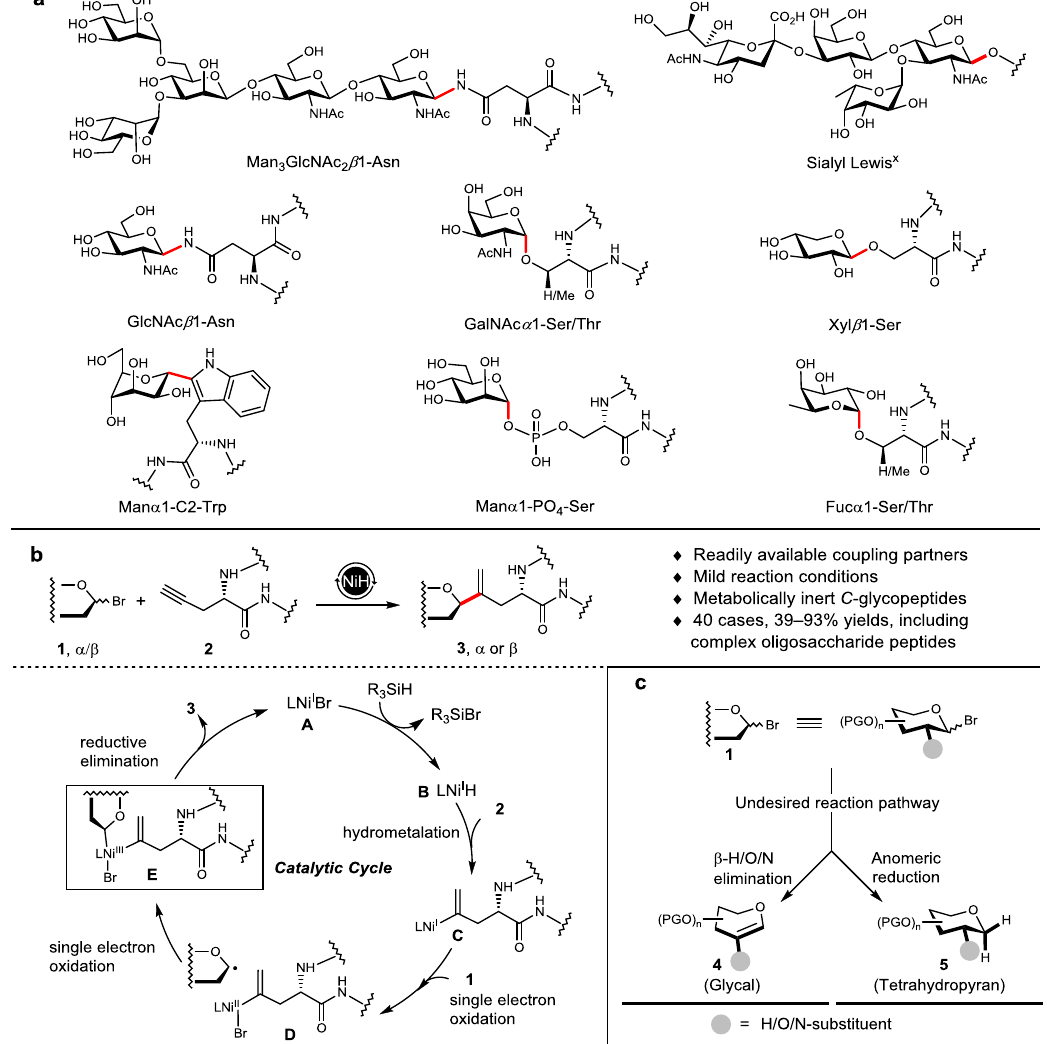
Fig. 1 Ni-catalyzed syntheses of vinyl C -glycosyl amino acids and peptides. a The N -linked core Man 3 GlcNAc 2 β 1-Asn motif in glycoproteins, the O -linked tumor-associated carbohydrate antigen Sialyl Lewis x in glycolipids, and the native N / O / C -glycosidic linkages in glycoproteins. b Nickel-catalyzed reductive hydroglycosylation for access to vinyl C -glycopeptides and a plausible mechanism. c Structure of the glycosyl donors 1 and potential by-products 4 and 5 . The glycosidic bonds are highlighted in